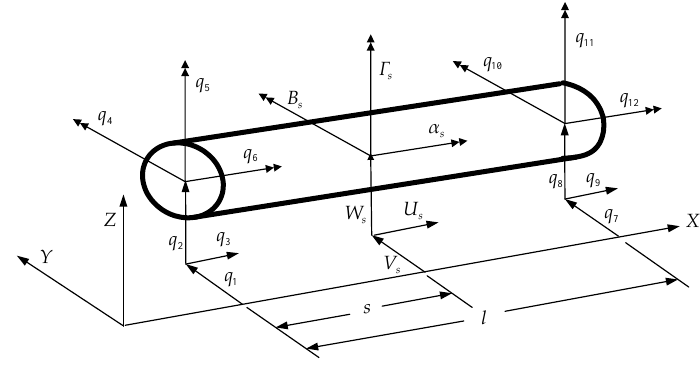
Figure 2. Shaft element and coordinate system.